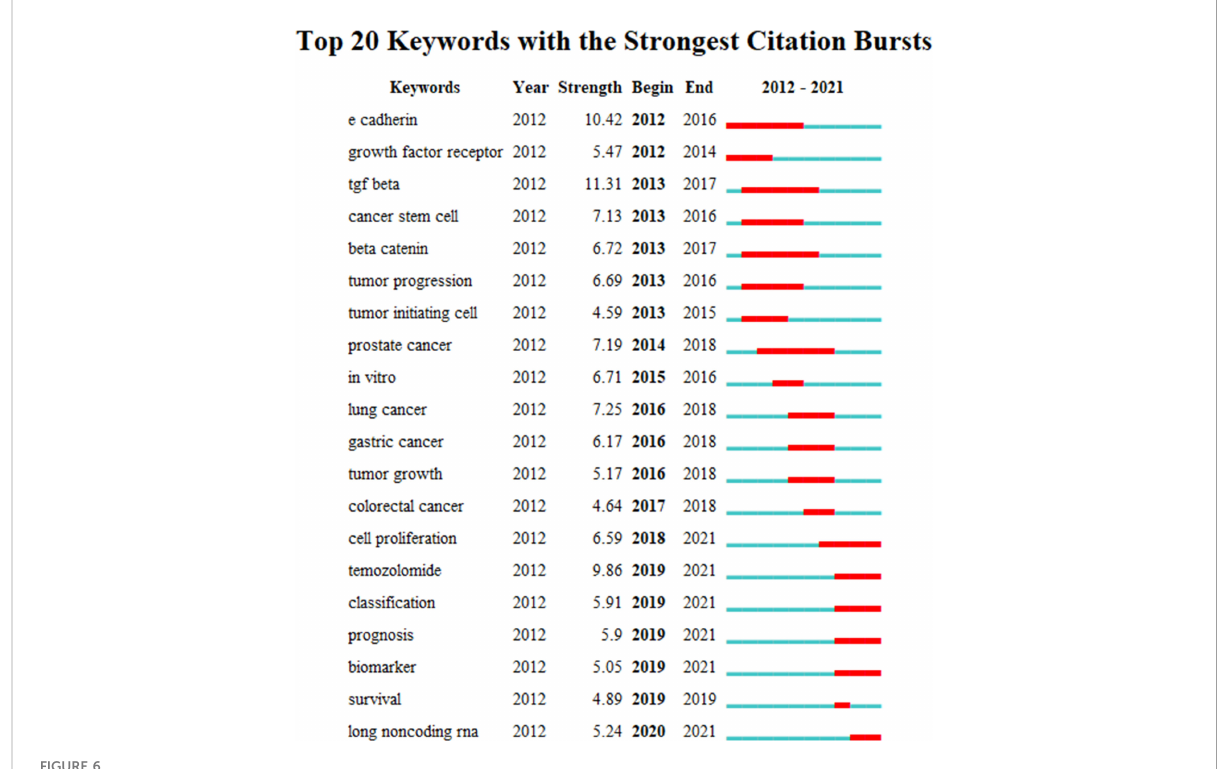
FIGURE 6 The top 20 keywords with the strongest citation